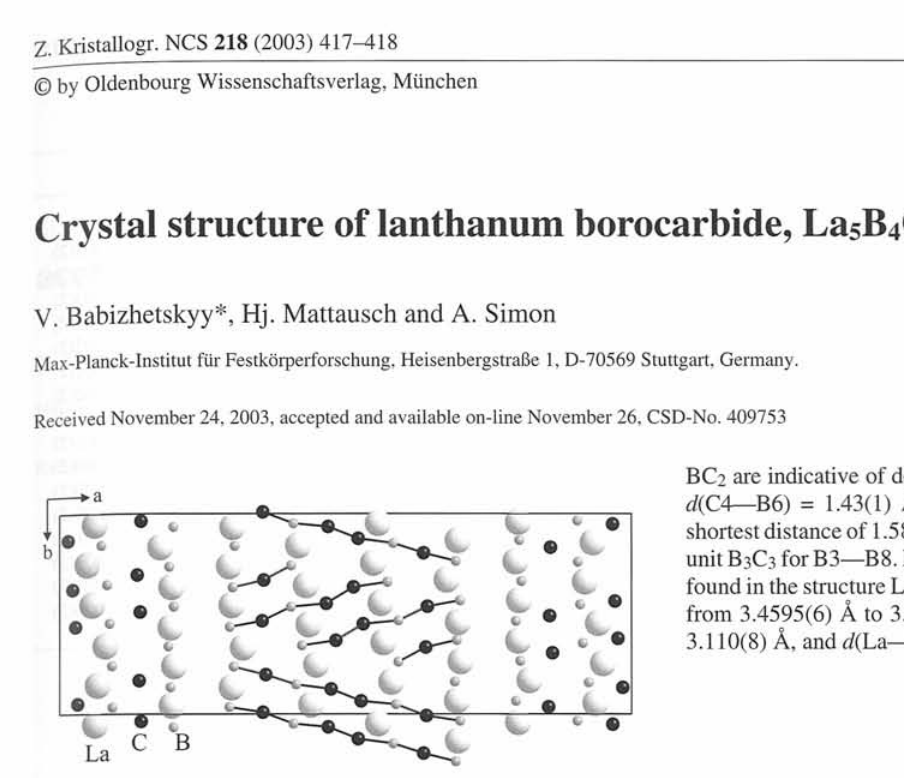
Table 1. Data collection and handling.